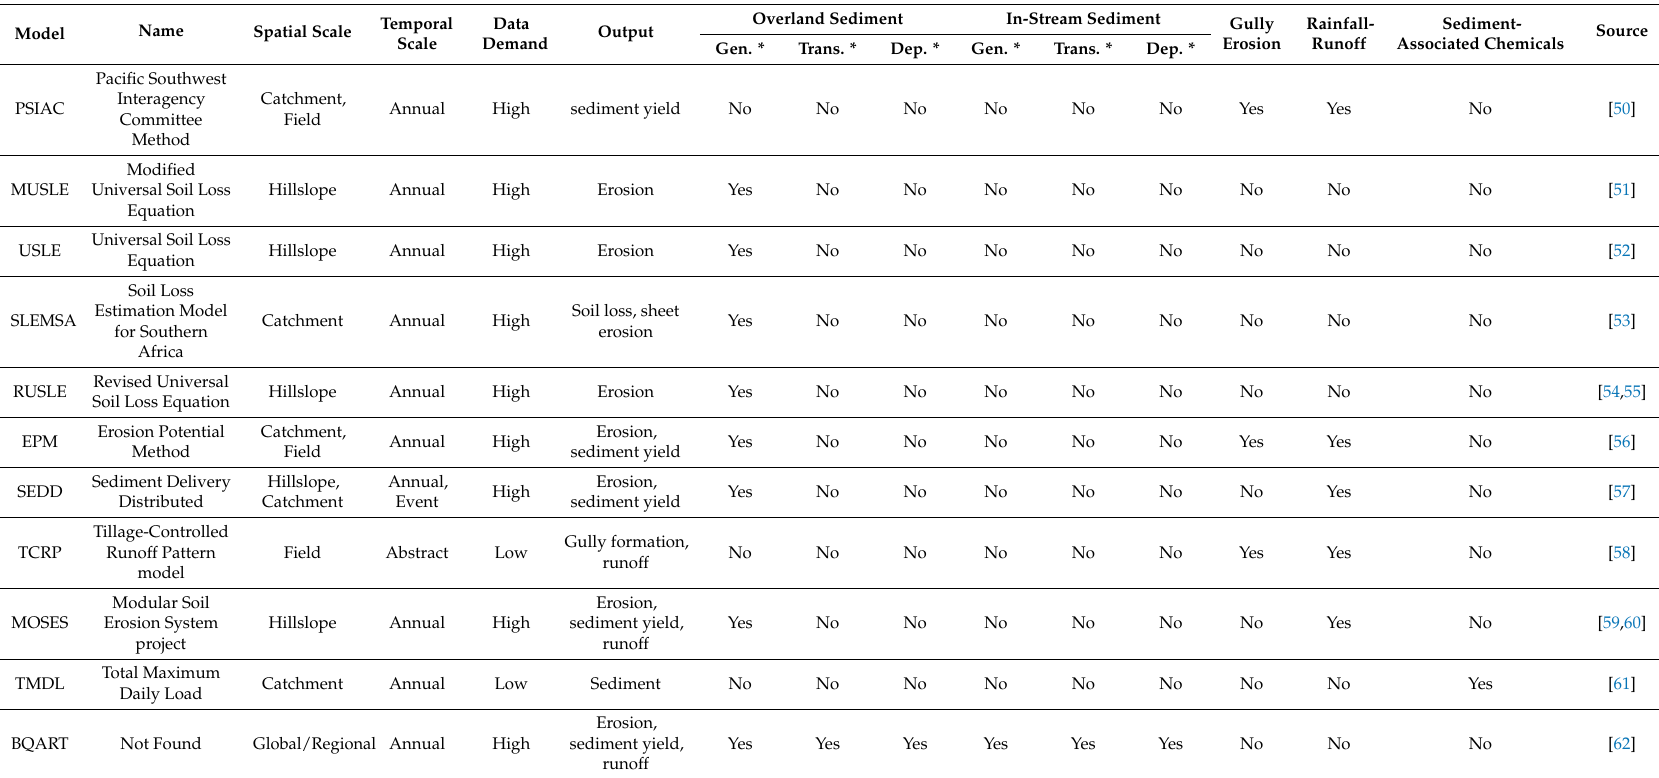
Table 1. Empirical soil erosion